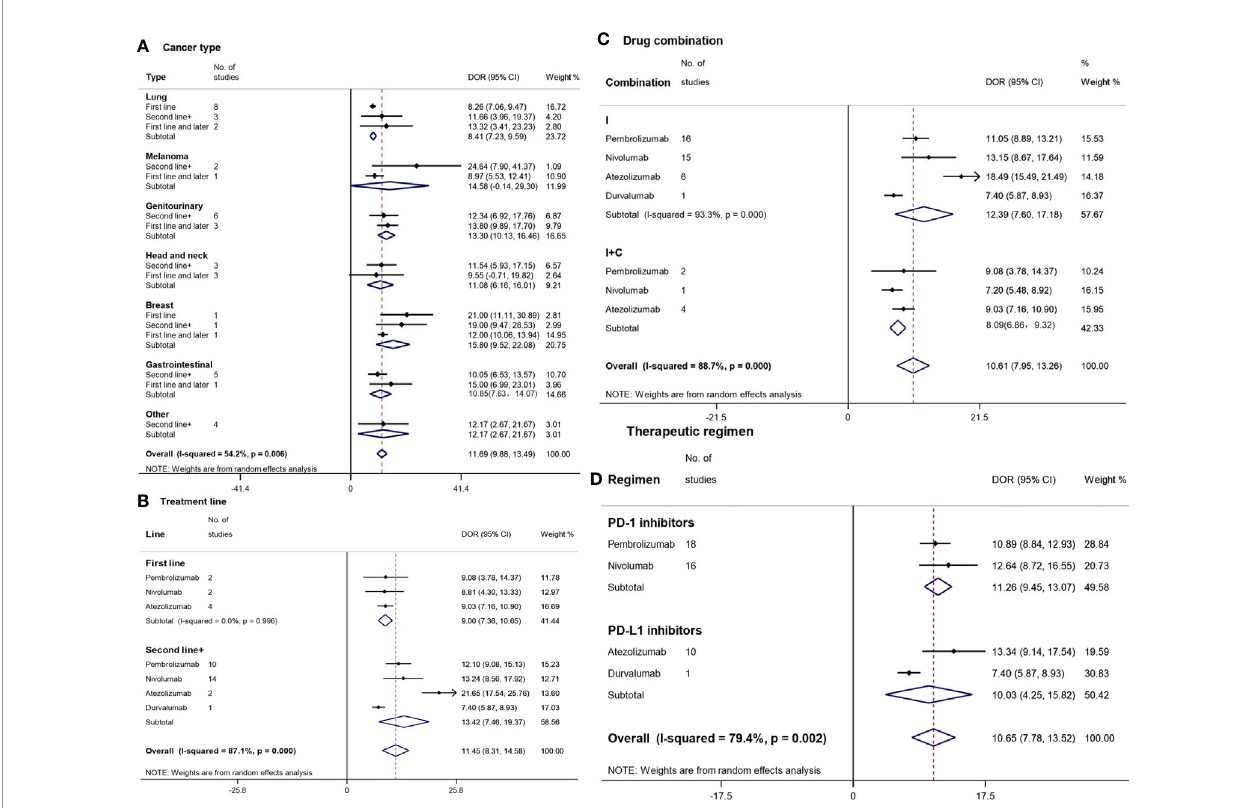
FIGURE 4 | Forest plot for duration of response (DOR) by cancer type (A) , treatment line (B) , drug combination (C) , and therapeutic regimen (D) . Squares represent study-speci fi c effect sizes (DOR). The area of a square is inversely proportional to the standard error of the study (and therefore indirectly to the sample size), and a larger area indicates greater weight in the calculation of the pooled effect size. The horizontal line crossing the square represents the 95% CI. The diamonds represent the estimated overall effect based on the meta-analysis. CI, con fi dence